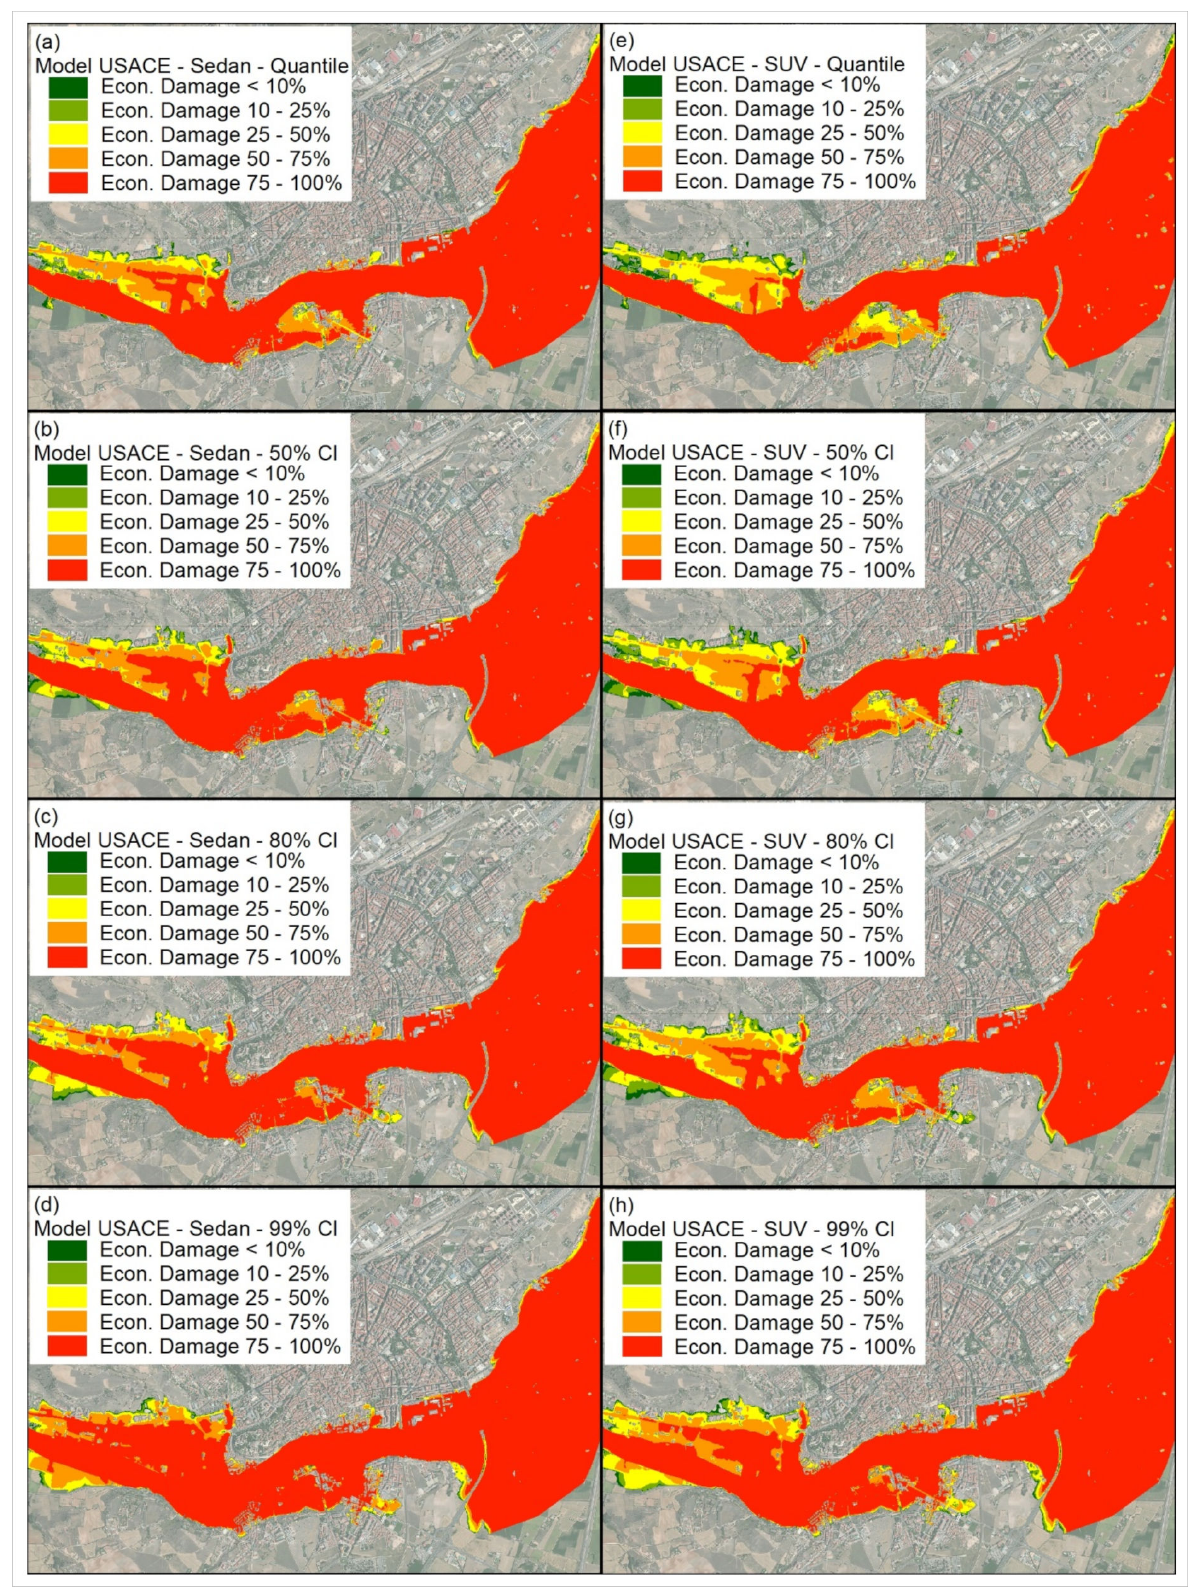
Figure 7. Probabilistic map of economic damage to vehicles (%) areas in Zamora city (Spain) from the USACE [46] model for sedan-type vehicles ( a – d ), and SUV-type vehicles ( e – h